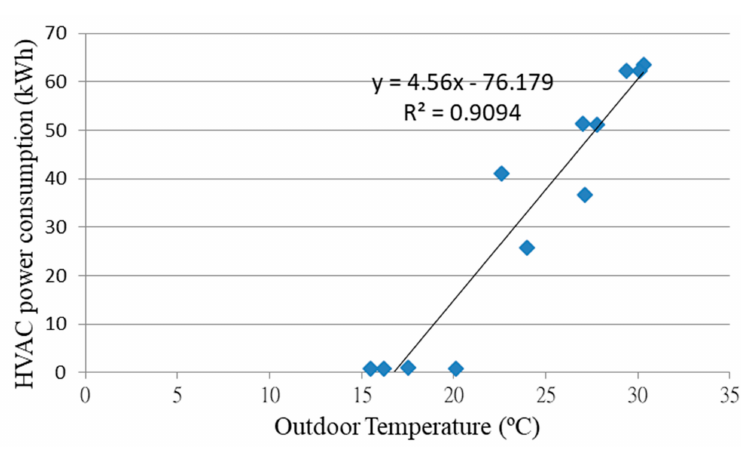
Figure 8. Energy consumption regression model of the chilled water system.